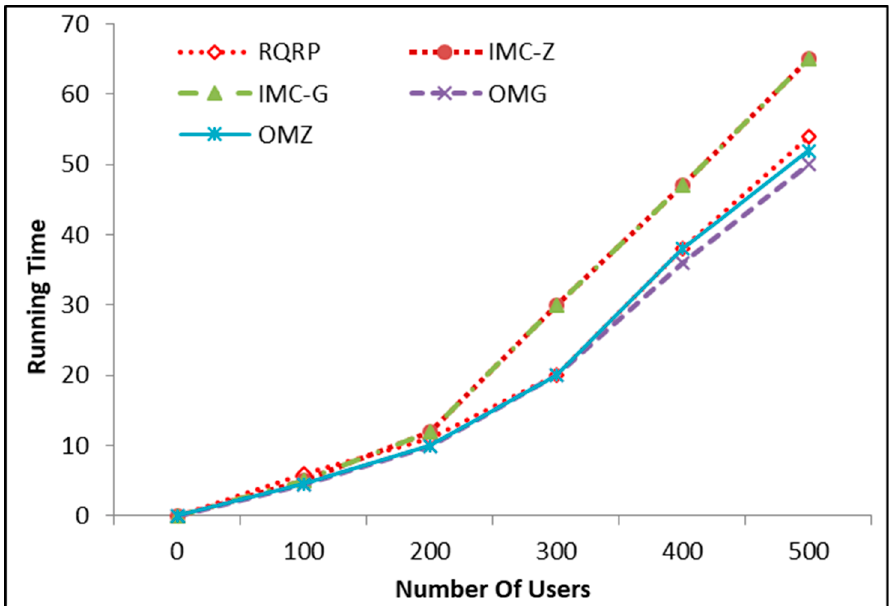
Figure 4. Comparison of running time with some of the approaches from the literature. IMC-G: incentive mechanisms for crowdsensing systems under general case; IMC-Z: incentive mechanisms for crowdsensing systems under zero case.